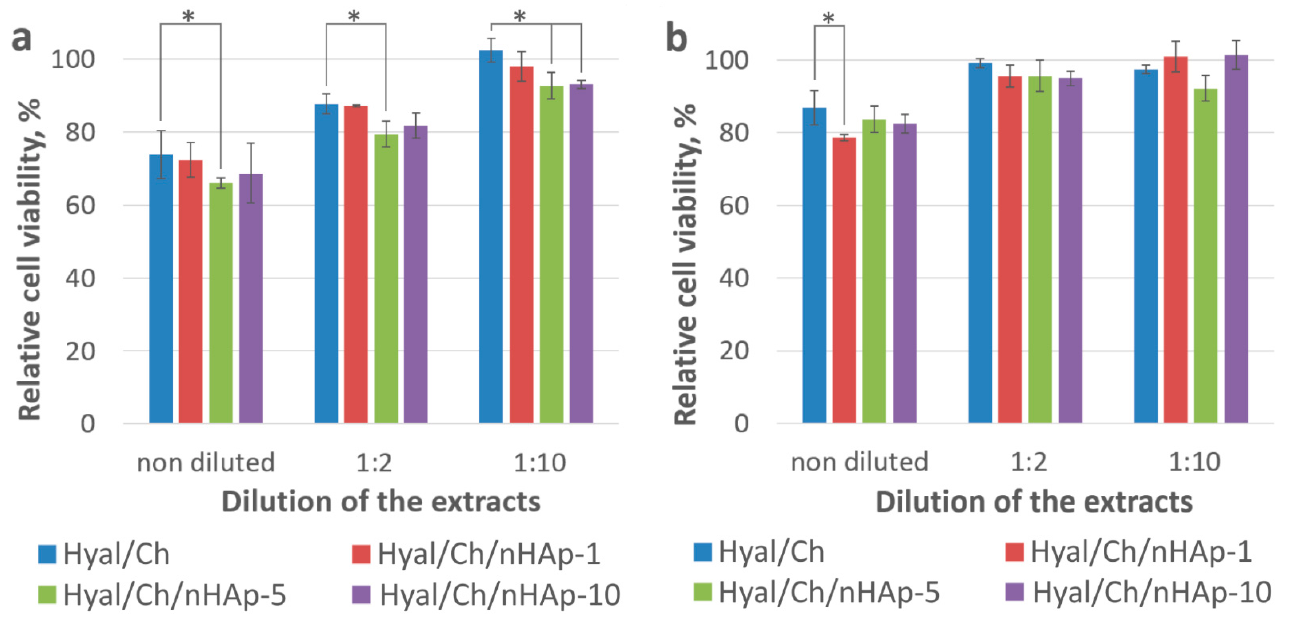
Figure 5. Viability of the L929 ( a ) and HOS ( b ) cells after incubation with the non-diluted extract and